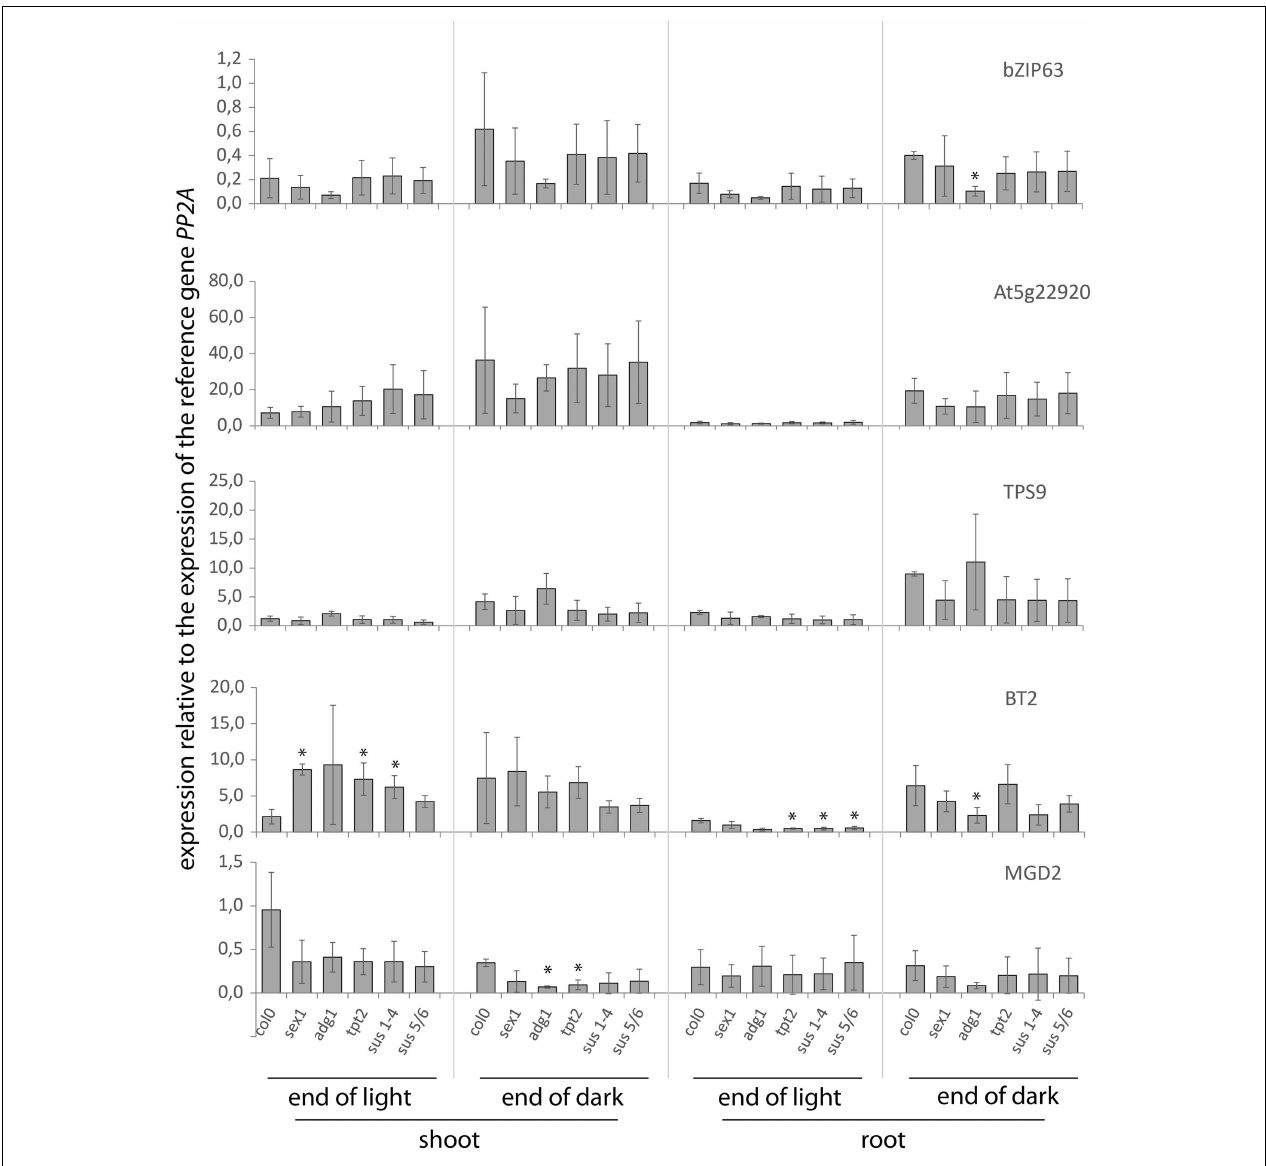
FIGURE 2 | Expression of selected genes in shoots and roots of A. thaliana wt plants and mutants impaired in CH-metabolism. Plants were grown for 13 days on agar under 16h light/ 8h dark photoperiod, and the samples were taken both